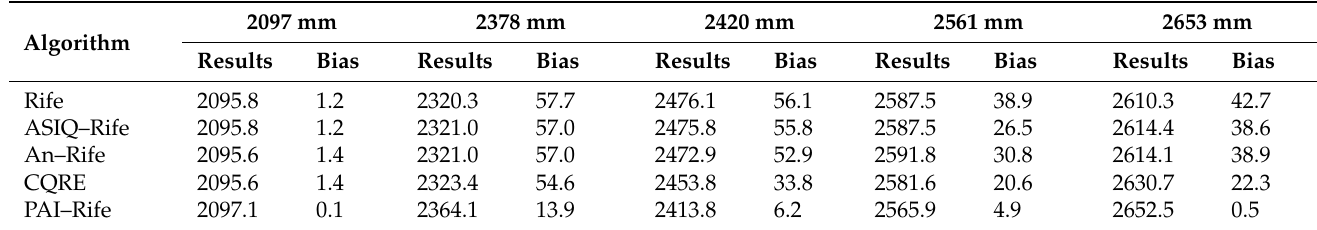
Table 3. Comparison of distance values obtained by different